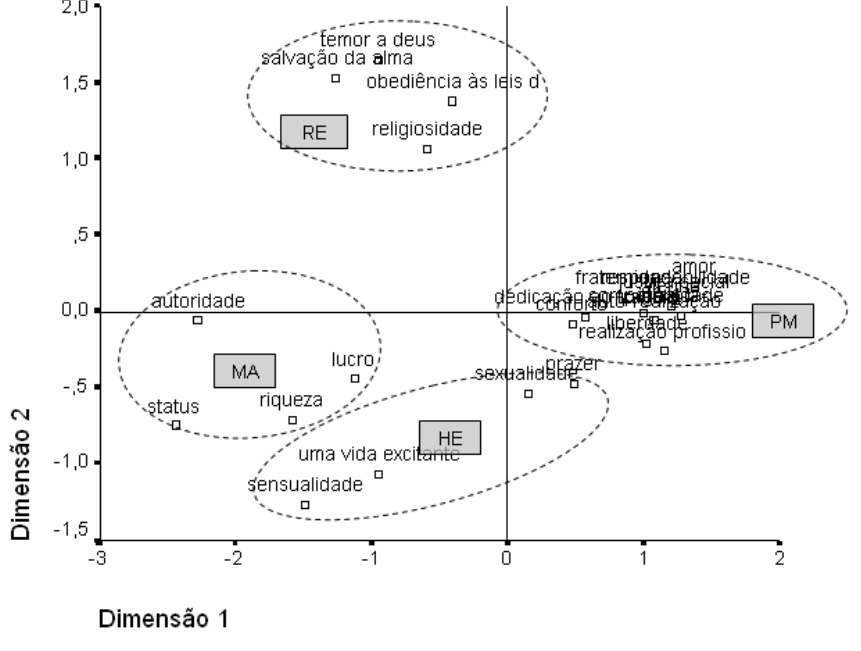
Figura 1. Agrupamento dos valores psicossociais. Nota . RE=Sistema religioso; PM=Sistema pós-materialista (o agrupamento apresentado em forma de mancha por sobreposição dos valores indica a alta proximidade existente entre eles); HE=Sistema hedonista; MA= Sistema